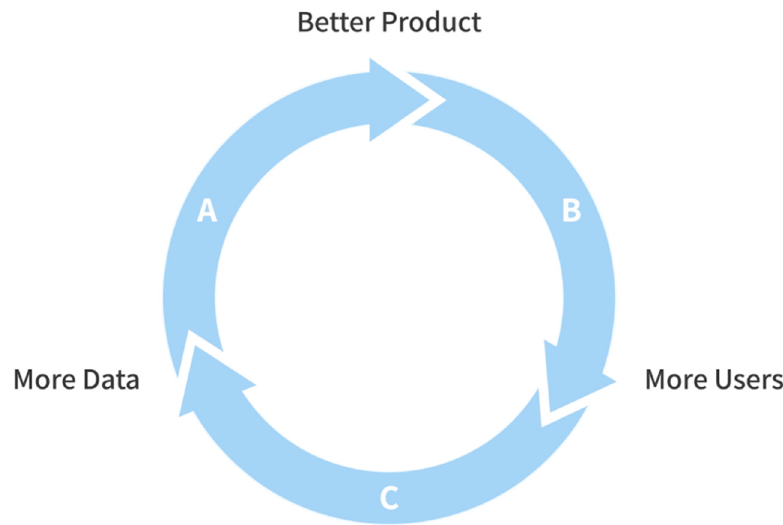
Figure 3. The virtuous cycle of AI.